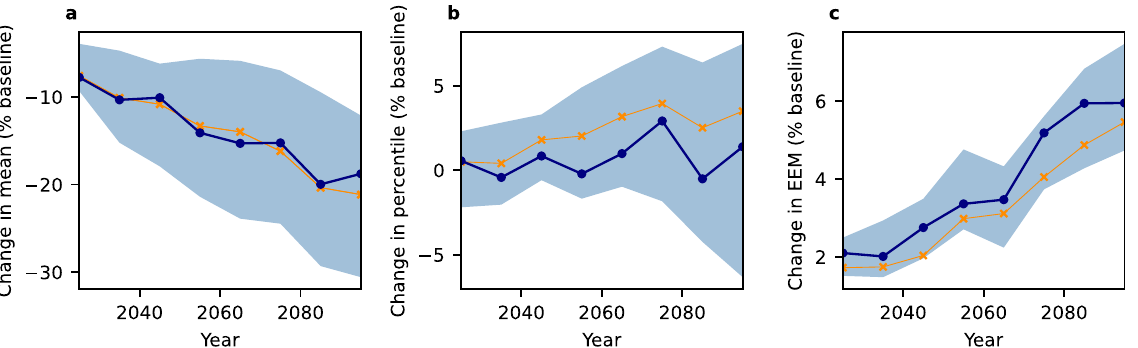
Figure 3. Contrasting global trends of mean daily snowfall and extreme snowfall measures (elevation below 1000 m, decadal statistics, Northern Hemisphere north of 40 °N, SSP5-RCP8.5). All values are area-weighted and relative to the baseline (1851–1920) climate. ( a ) Mean, ( b ) 99.9th percentile, ( c ) expected extreme magnitude above the 99.9th baseline percentile. Blue line shows the model ensemble median, shaded areas denote the likely range (16.7th to 83.3rd percentiles). Orange line shows statistics for all ten models combined into one time series ensemble.